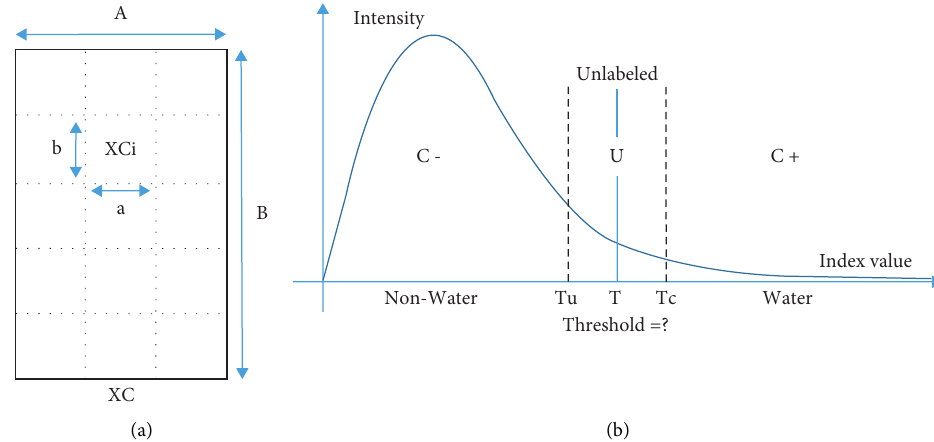
Figure 2: (a) Illustration of the SBA for scene image XC with size A xB and subscene image XCi with size ax b. (b) Graphical illustration of the distribution of pixel values for the two classes water ( C +) and nonwater ( C − ) , and unlabeled class ( U ) for which the threshold value ( T � ? ) is needed as a boundary between the water and nonwater